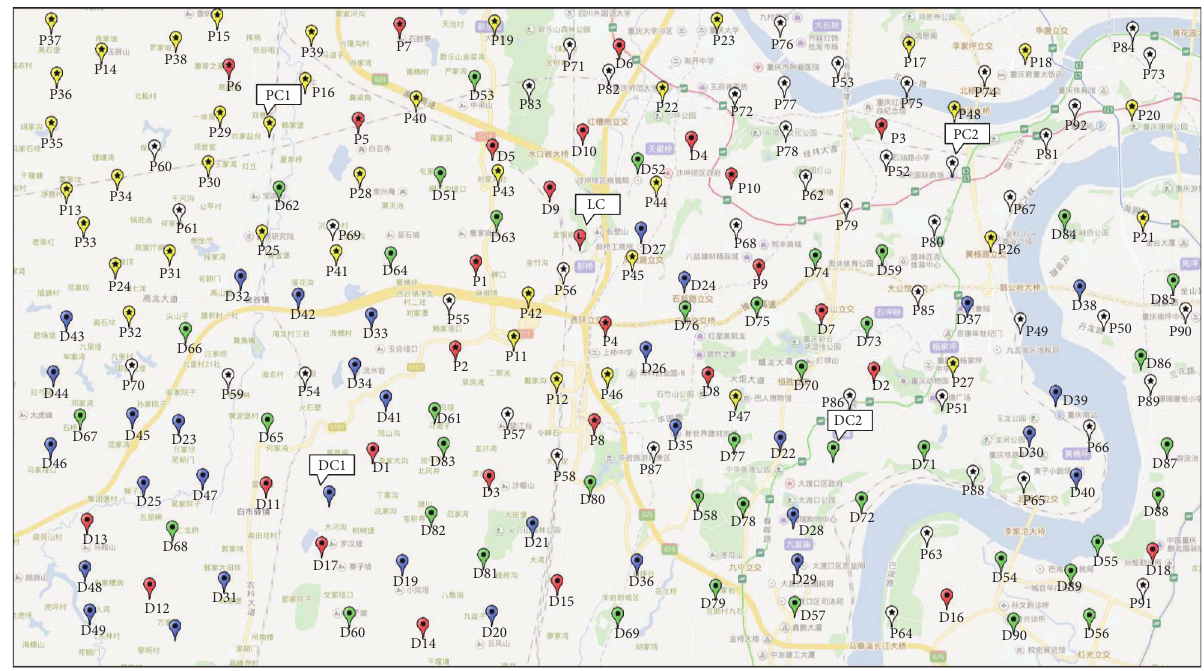
Figure 6: Geographic layouts of the LC, DCs, PCs, and